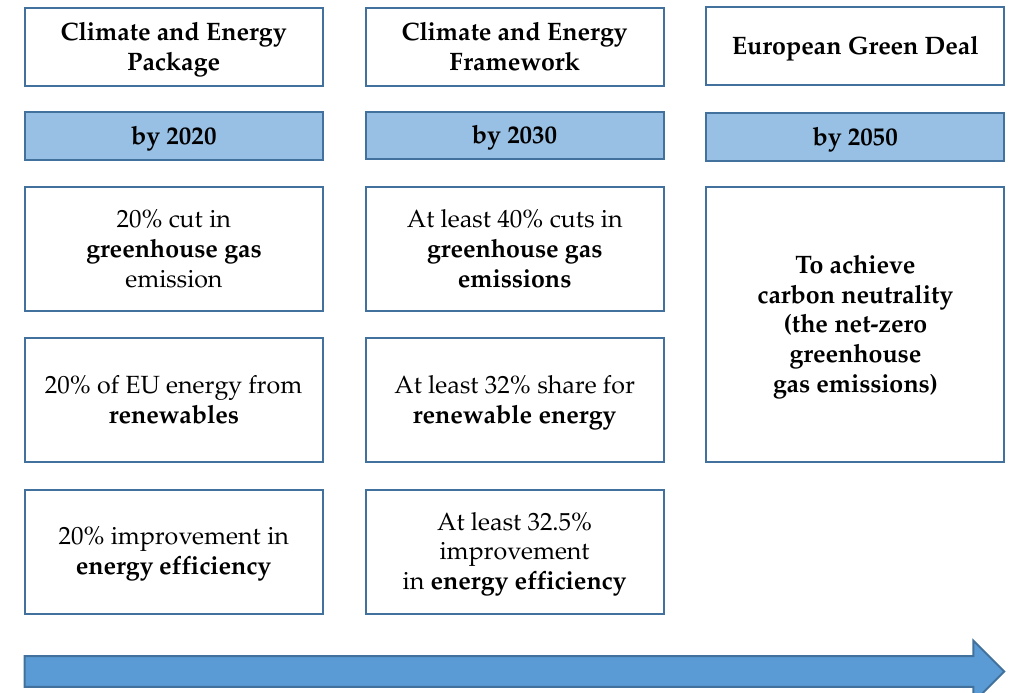
Figure 1. The current EU energy policy framework and targets by 2030 and 2050. Source: own compilation based on the EU documents and strategies.